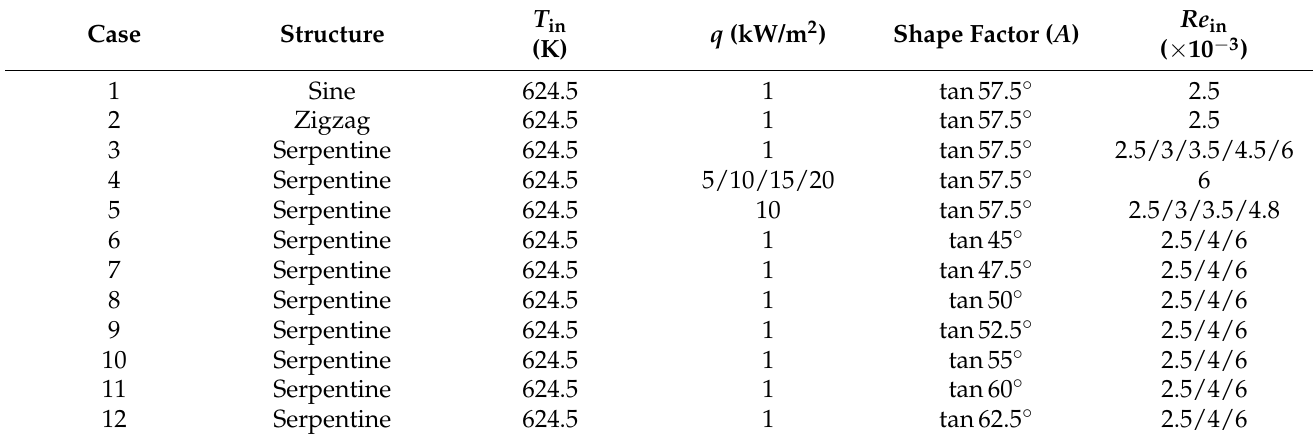
Table 1. Detailed information on the simulation